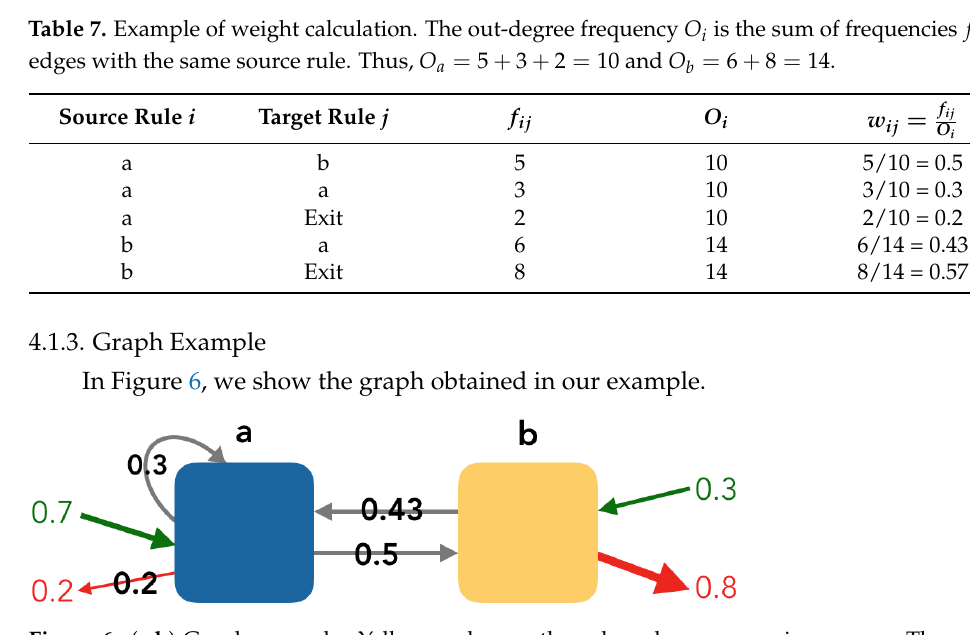
Figure 6. ( a , b ) Graph example. Yellow nodes are the rules where conversion occurs. The arrow thickness corresponds to the edge weight. The green (respectively, red) arrows indicate the entry (respectively, exit) rate. The values in the middle of the arrows indicate the weight of the edge ( w ij ). If there were edges with a weight <0.05, they would be in a lighter grey, and their weight would not be